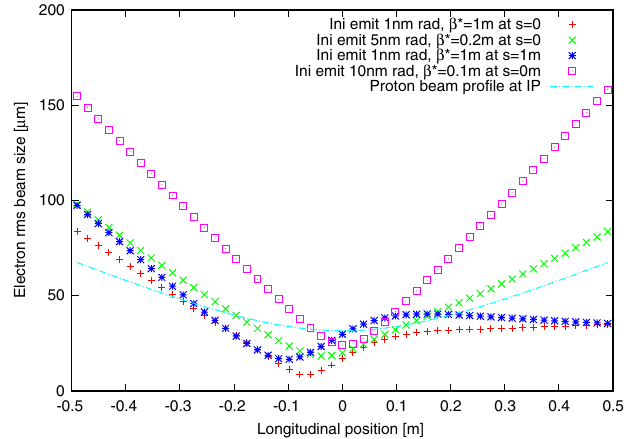
FIG. 9. (Color) Evolution of the size of the electron and proton beam under different optics and initial emittances. The proton beam travels from left to right, and the electron beam travels from right to left.